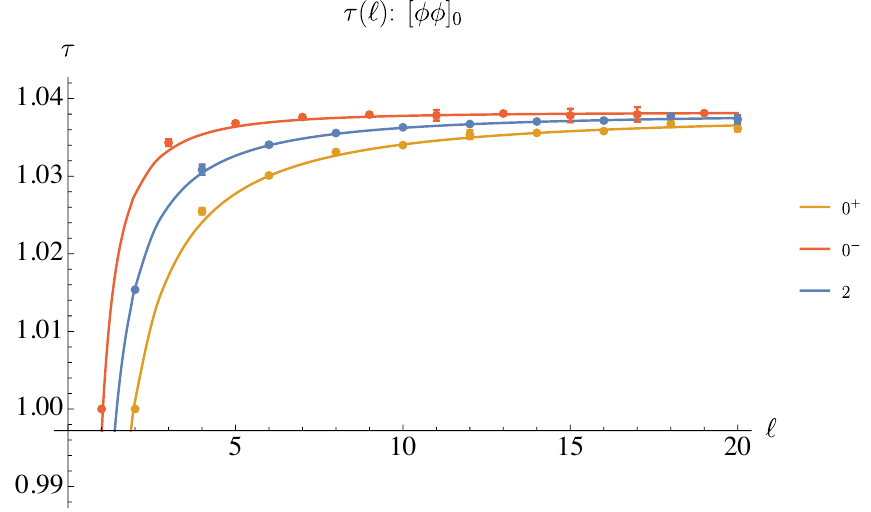
Figure 3 . Analytical and numerical predictions for the twists (cid:28) = (cid:1) (cid:0) ‘ of the leading-twist Regge trajectories [ (cid:30)(cid:30) ] 0 (cid:6) ; 2 in the charge sectors 0 (cid:6) ; 2 as a function of spin ‘ . The lowest trajectory 0 corresponds to charge 0 + (the trivial representation of O(2)). Note that both the spin-2 operator in the charge 0 + sector and the spin-1 operator in the charge 0 (cid:0) sector have twist 1, corresponding to the stress tensor and O(2) current,